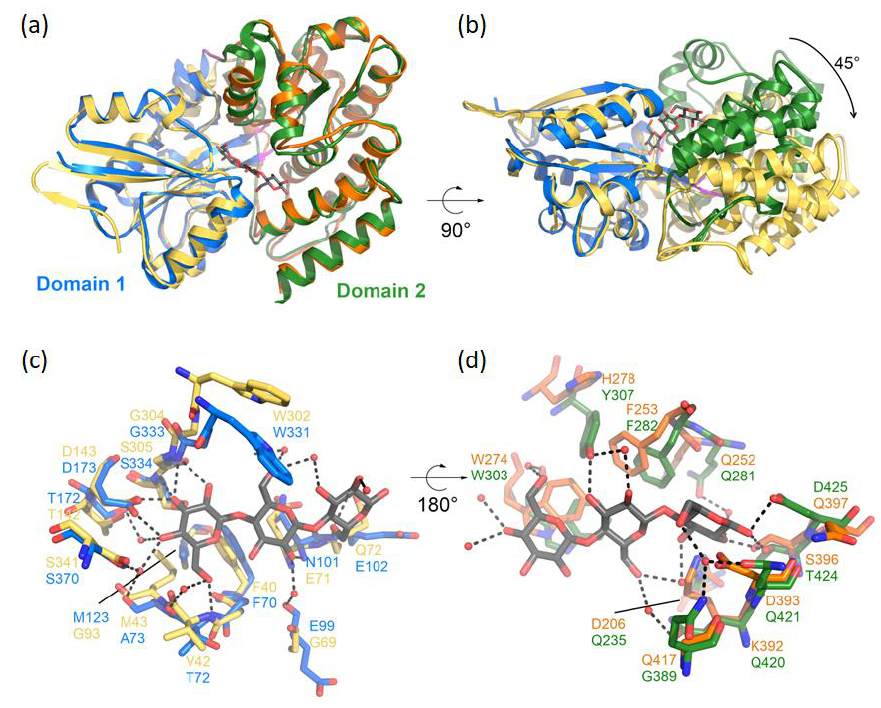
Figure 7. 3D model of CebE2. ( a ) Cartoon representing the CebE1 (Domain 1 in blue and Domain 2 in green) structure in complex with cellotriose (grey sticks) with the two domains of CebE2 super- imposed separately (Domain 1 in yellow and Domain 2 in orange). ( b ) CebE1 (same coloring scheme as in ( a )) and CebE2 (yellow) with their Domain 1 superimposed, highlighting the 45° rotation ob- served between Domain 2 of both proteins. ( c ) Interactions (black dashed lines) between cellotriose (grey sticks) and Domain 1 of CebE1 (blue sticks), including through water molecules (red spheres). Equivalent residues in CebE2 are displayed as yellow sticks. ( d ) Same as ( c ) for Domain 2 with CebE1 in green and CebE2 in orange. The figure was prepared using PyMOL (The PyMOL Molec- ular Graphics System v2.5.2 Enhanced for Mac OS X, Schrödinger, LLC).